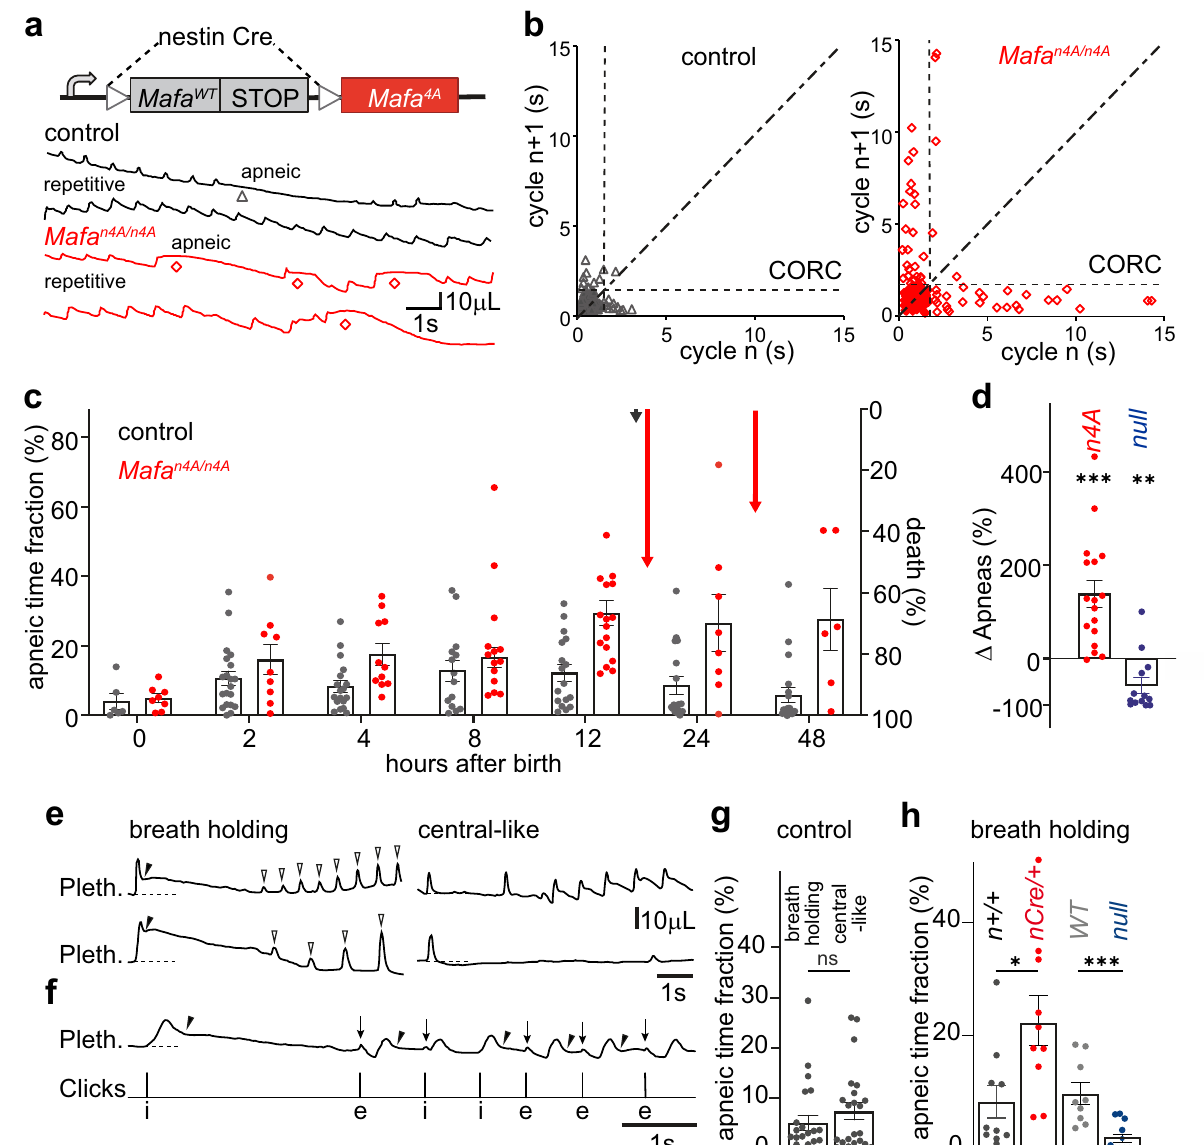
Fig. 1 Impaired Mafa phosphorylation in the nervous system results in lethal breath holding apneas. a Top, genetic scheme to introduce the Mafa4A mutation in neurons. Bottom, typical plethysmographic recordings (inspiration: upward) of control (black traces) and Mafa n4A/n4A (red traces) littermates at P0 + 12h showing repetitive and apneic breathing cycles (the superposed traces are adjacent segments of a continuous record). Apneas (gray triangle in controls) are more frequent in the mutant (red diamonds). b Poincaré plots of the duration of consecutive respiratory cycles n + 1 (ordinates) as a function of n (abscissae) in a control (left) and a Mafa 4A/4A (right, 5min recording samples). Repetitive short cycles ( fi lled symbols) are clustered on the diagonal below the CORC (vertical and horizontal dotted lines), apneic cycles (empty symbols) give points away from the diagonal beyond the CORC. Note that the Mafa n4A/n4A mutant shows an increased incidence of apneas. c Evolution of the apneic time fraction (left ordinates axis, bar plot) and mortality (right inverted ordinates axis, vertical arrows) in control (gray, n = 29) and Mafa n4A/n4A mutants (red, n = 21) pups. Each symbol represents measurement of a single pup (One-way ANOVA between the two genotypes P <0.0001, degree of freedom (df) = 1, F = 34.38.). d Percent relative change in the number of apneas (ordinates) compared to their controls for Mafa n4A/n4A (Statistical test between mutant and control littermates: n4A vs Cre + / + littermates n = 17 for both genotypes, two- sided unpaired t -test P = 0.0004, df = 32, t = 3.965) and Mafa LacZ/LacZ ( null n = 13 vs wild type n = 10 littermates, two-sided Mann – Whitney test P = 0.0041, U = 20). e Example traces of the two types of apneas in Mafa n4A/n4A mutant pups. At left, breath holding apneas characterized by post-inspiratory onset (black arrowheads) of limited expiratory fl ow prolonging lung in fl ation (plateau above dotted baseline) followed by the resuming of inspiratory efforts of progressively increasing amplitudes (empty arrowheads). At right, central-like apneas characterized by normal inspiratory and expiratory phases separated by an abnormally long pause during which the lung is de fl ated. f Joint plethysmographic (top trace) and click audio recordings (bottom trace) during an epoch of breath holding apneas. Clicks that follow a post-inspiratory (arrowheads) breath holding apnea are associated to small upward pressure shifts (downward arrows) that immediately precede onset of an expiration (e below the click trace, 4 of 5 clicks) de fl ating the lung or occasionally an inspiration (i below the click trace, 1 of 5 clicks,) further in fl ating the lung. g Quanti fi cation of the apneic time fraction for apnea types in control pups ( Mafa fl ox4A/4A , n = 23) at P0 + 12h (two-sided Mann – Whitney test P = 0.4100, U = 226.5). h Quanti fi cation of the breath holding apneic time fraction in Mafa n4A/n4A (nCre/ + , n = 10 pups, red) , Mafa null ( n = 13 pups, blue) and that of respective control ( n + / + , n = 10 pups, gray, two-sided unpaired t -test P = 0.0145, df = 18, t = 2.704) and wild type (light gray, n = 9 pups, two-sided Mann – Whitney test P = 0.0052, U = 14) littermates. Plots represent